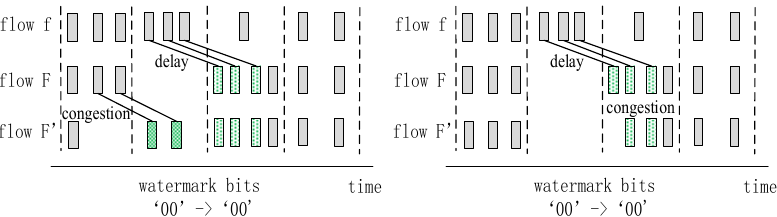
Figure 6. An example of the decoding result of watermark ‘00’ when micro-packet delay and micro-packet loss occur.